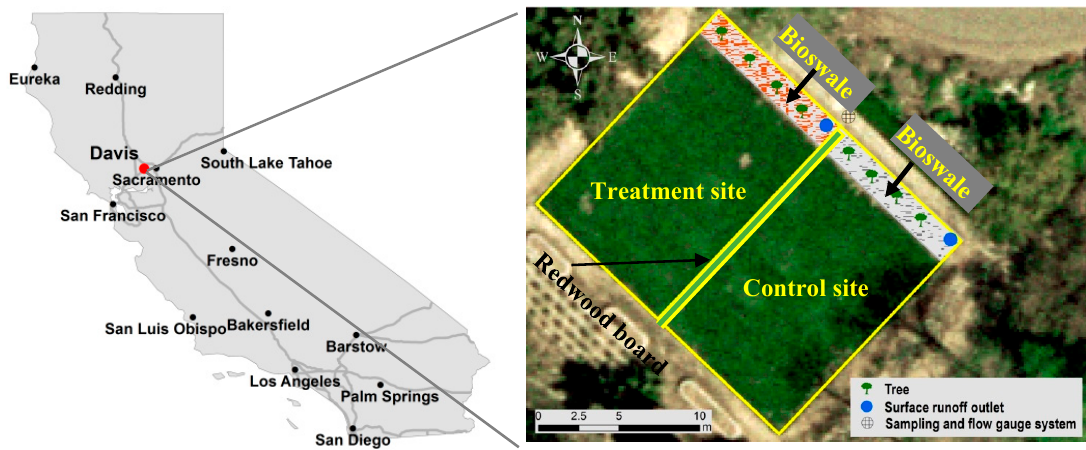
Figure 1. Study site and experimental design. The map on the left shows relative geographic location within the state of California. The map on the right shows the experimental setup.